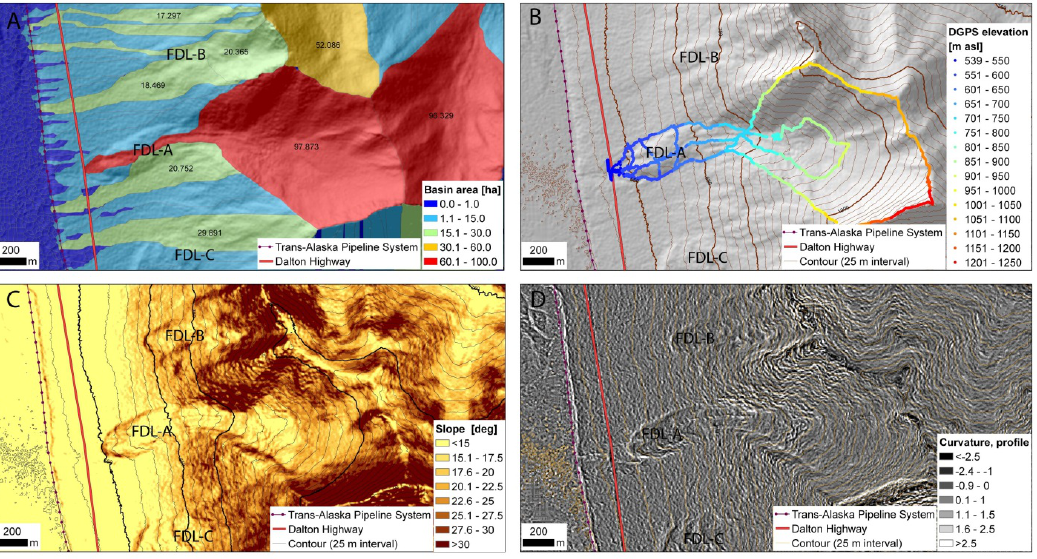
Fig. 2. IfSAR DEM-derived morphometric characteristics of frozen debris-lobe A (FDL-A). (a) Watershed area (ha) contributing to FDL-A (ca. 98hectare); (b) shaded relief map with contour lines and an overlay of DGPS data, observed points are forming a line; (c) slope map; (d) curvature map.